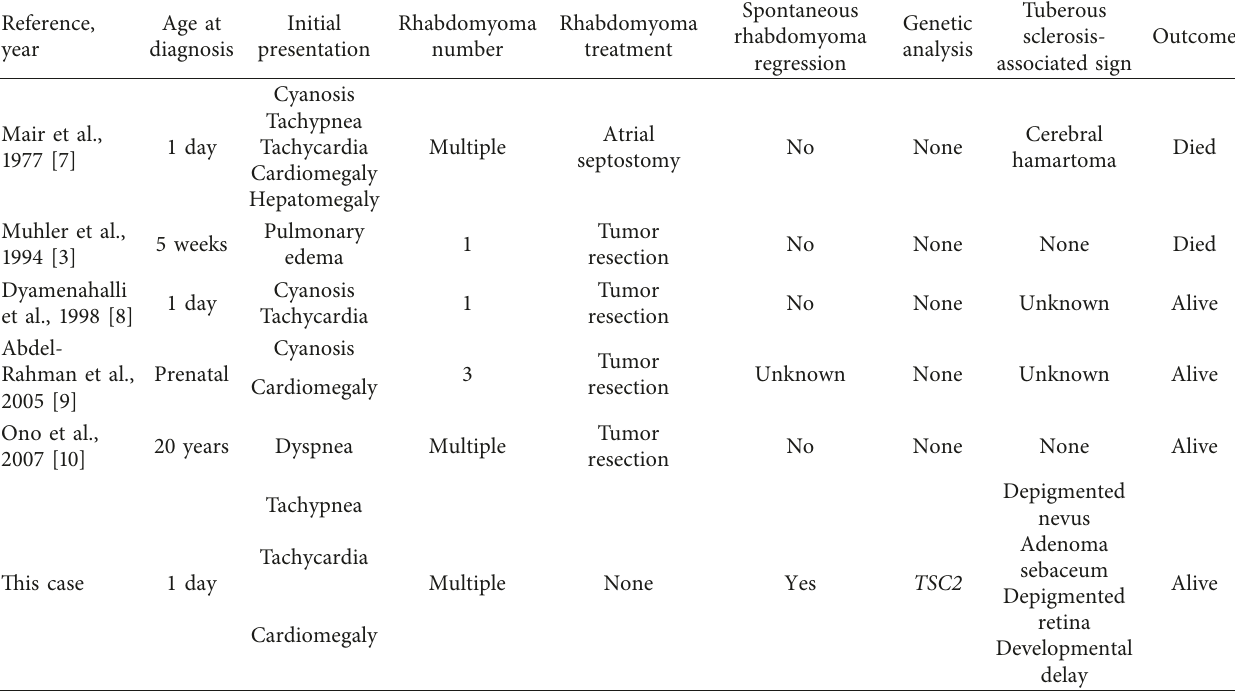
Table 1: Clinical features of patients with significant LV inlet obstruction caused by cardiac rhabdomyoma.